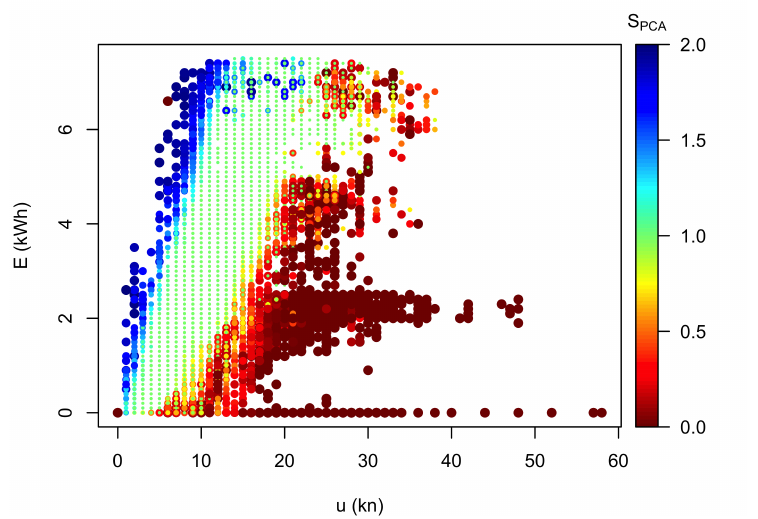
Figure 9. Performance curve for the validation period with colour coding for S PCA .